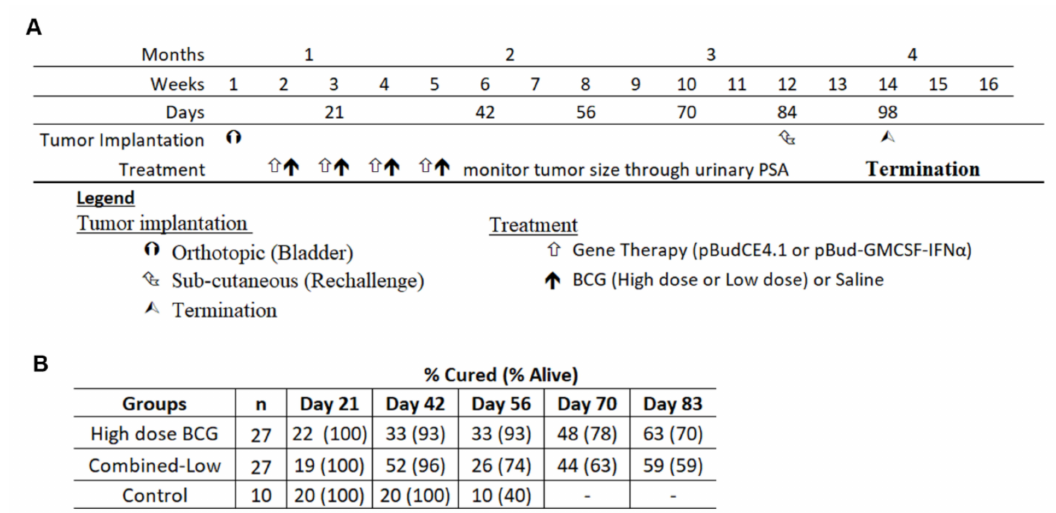
Figure 4. The experimental plan for the long-term experiment and monitoring of tumor growth. ( A ) The plan of therapy and long-term monitoring are shown and dates when urine was collected for analysis of PSA. ( B ) The cured status was determined by measuring urinary PSA and normalizing to creatinine